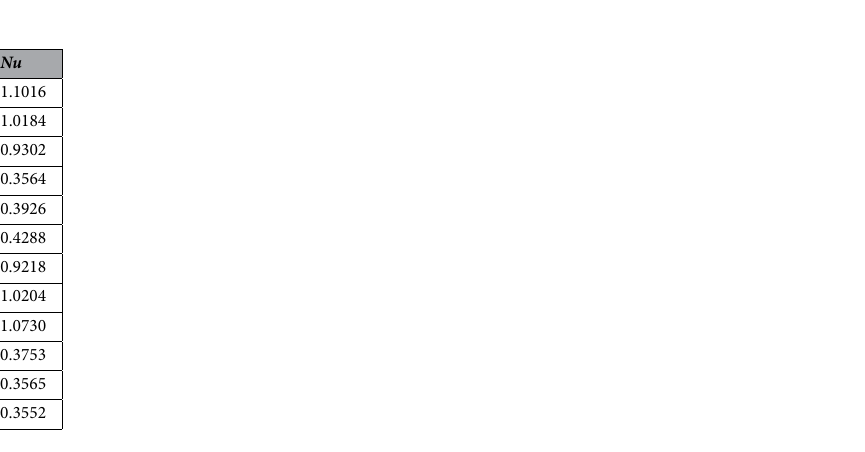
Figure 39. τ versus t for different t 1 and Sc = 0.22, K = 2, N = 3, Pr = 0.71, Du = 0.5, M = 0.5, K* = 3, Gr = 1, Gm = 5, a = 1.